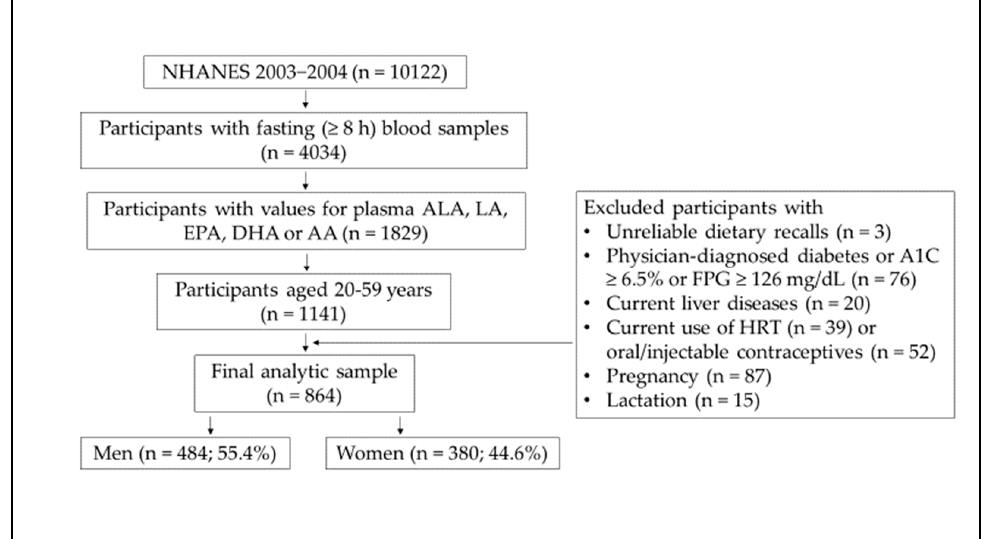
Figure 1. Flow chart of National Health and Nutrition Examination Survey (NHANES) 2003–2004 analytic sample. A1C, hemoglobin A1C; FPG, fasting plasma glucose; HRT, hormone replacement therapy; %, sample-weighted percentage; sample sizes ( n ) were presented as unweighted.